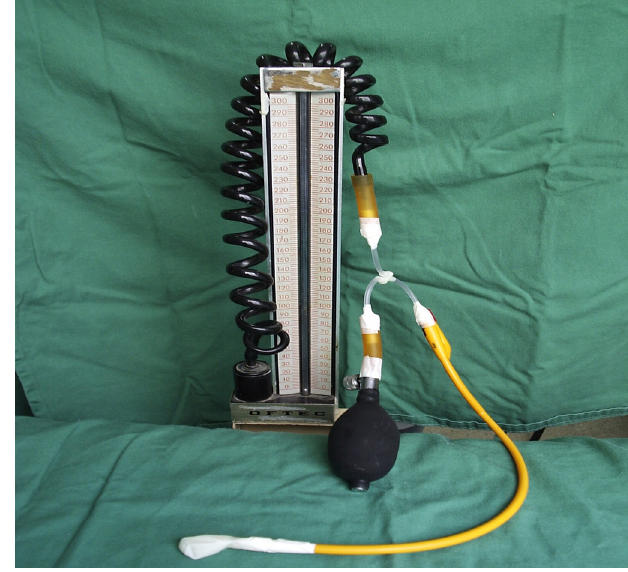
FIGURE 4 – Apparatus used to assess tensile